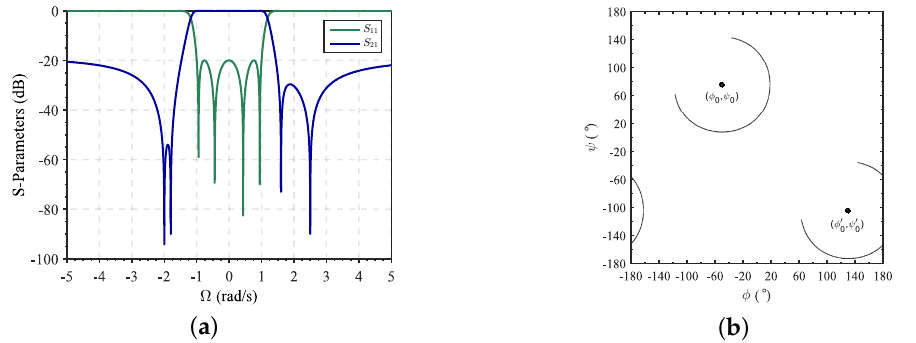
Figure 8. ( a ) S-parameters of the network with Ω Ek TZs and ( b ) the phase map of the ellipse with a sweep between ± 180 ◦